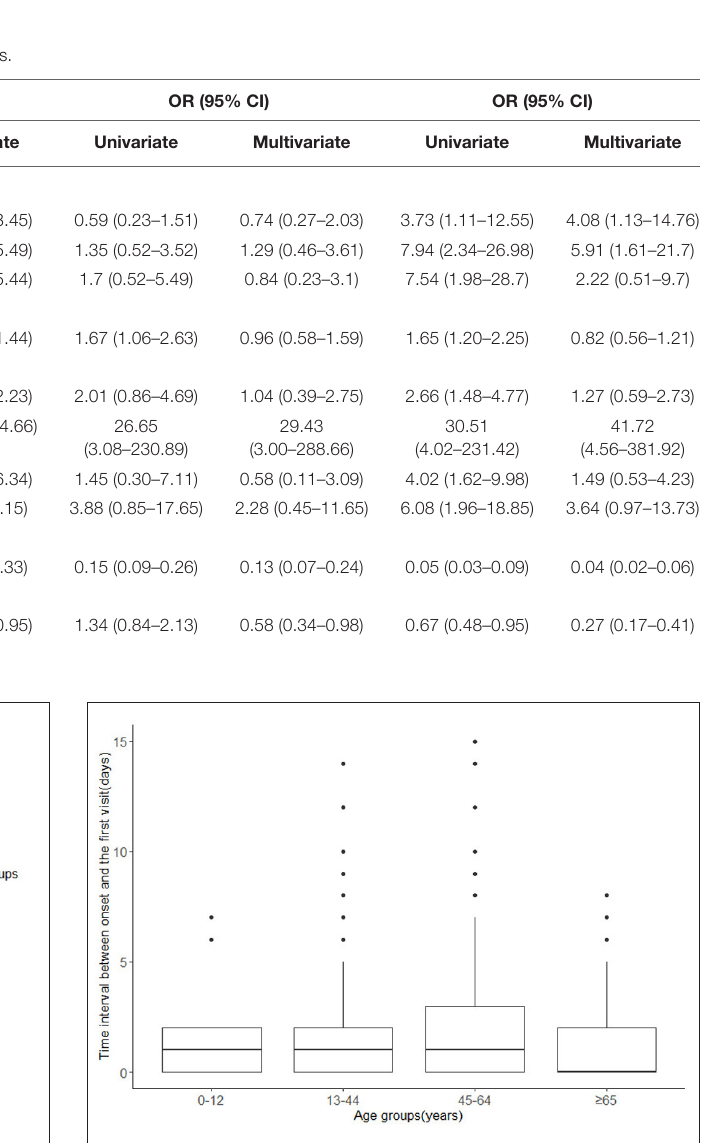
FIGURE 3 | Bar chart of proportions of the groups with obvious symptoms at different time intervals.